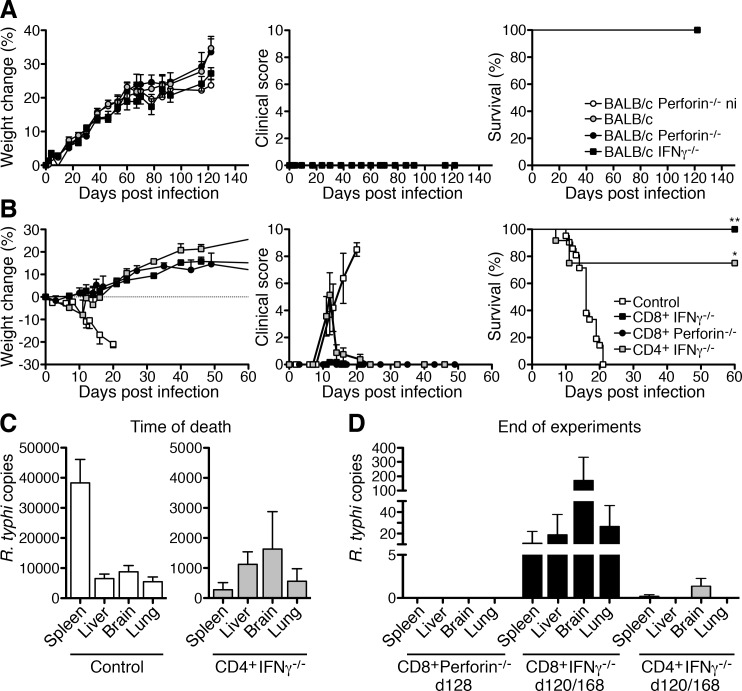
CD8+Perforin-/-, CD8+ IFNγ-/- and CD4+IFNγ-/- T cells are still protective.BALB/c wild-type mice (gray circles; n = 5), BALB/c Perforin-/- (black circles; n = 5) and BALB/c IFNγ-/- mice (black squares; n = 5) were infected with 1×106 sfu R. typhi. Non-infected BALB/c Perforin-/- mice (white circles; n = 5) were used as a control. Weight change (left), clinical score (middle) and survival (y-axis) was assessed at indicated points in time (x-axis) (A). CD8+ and CD4+ T cells were isolated from BALB/c Perforin-/- and IFNγ-/- mice. 1×106 CD8+ IFNγ-/- (black squares), CD8+ Perforin-/- (black circles) and CD4+ IFNγ-/- T cells (gray squares) were adoptively transferred into CB17 SCID mice 1 day prior to the infection with 1×106 sfu R. typhi. Control animals were treated with PBS instead receiving T cells (white squares). Weight change (left; n = 5 for each group), clinical score (middle; n = 5 for each group) and survival (right; n = 5 for CD8+ Perforin-/- recipients and n = 10–11 for CD8+ and CD4+ IFNγ-/- recipients) was assessed (y-axis) at indicated points in time (x-axis). The survival graph shows combined results from 2 independent experiments. Statistical analysis was performed with Log-rank (Mantel-Cox) test. Asterisks indicate significant differences compared to control animals (*p<0.05, **p<0.01) (B). All R. typhi-infected CB17 SCID control animals and two mice of the CD4+ T IFNγ-/- cell recipient group died until day 20. At the time of death, the bacterial load (y-axis) was determined in the indicated organs (x-axis) in these animals (C). The bacterial load (y-axis) was also determined in the organs of surviving animals. Organs were taken at indicated points in time from CD8+Perforin-/- (day 128 post infection; n = 4), CD8+ IFNγ-/- (n = 6) and CD4+IFNγ-/- T cell recipients (n = 8). For the transfer of CD8+ IFNγ-/- and CD4+ IFNγ-/- T cells the results from two independent experiments that were terminated on day 120 and day 168 post infection are shown (x-axis). The bacteria were not detectable at all in CD8+Perforin-/- T cell recipients while low amounts of R. typhi were present in five animals of the CD8+ IFNγ-/- and two mice of the CD4+IFNγ-/- T cell recipient groups. The figure shows the bacterial content in the organs of all animals (mean±SEM) (D).